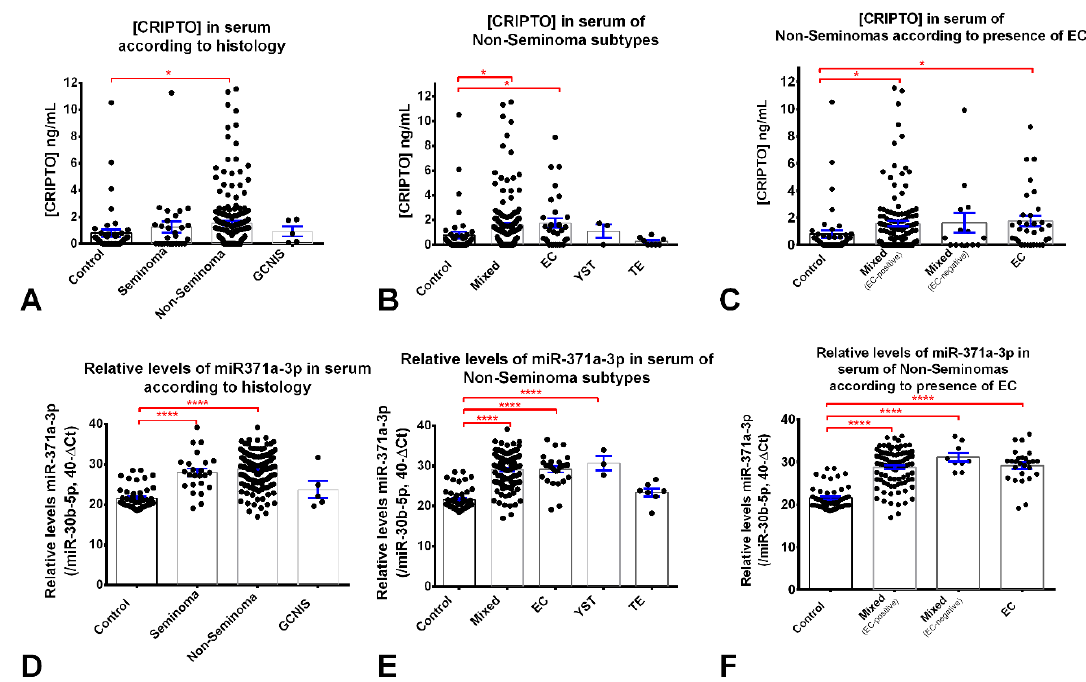
Figure 1. CRIPTO concentration and miR-371a-3p relative levels in the serum cohort, according to histological group. CRIPTO concentration (ng / mL) assessed by ELISA (( A ) Kruskal–Wallis test p -value = 0.0232) and miR-371a-3p relative levels assessed by RT-qPCR (( D ), Kruskal–Wallis test p -value < 0.0001) in serum of controls (healthy blood donors, n = 48), seminoma ( n = 27), non-seminoma ( n = 190) and GCNIS-only patients ( n = 5); in serum of controls and the various non-seminoma subtypes (( B , E ) Kruskal–Wallis test p -values of 0.0055 and < 0.0001); and in serum of controls and non-seminoma patients with and without EC (( C , F ) Kruskal–Wallis test p -values of 0.0111 and < 0.0001). Error bars represent mean ± S.E.M. Relative levels of miR-371a-3p were normalized with miR-30b-5p and plotted in 40- ∆ Ct format. Abbreviations: EC—embryonal carcinoma; GCNIS—germ cell neoplasia in situ; YST—yolk sac tumor; TE—teratoma; S.E.M.—standard error of mean. * p < 0.05; **** p < 0.0001.